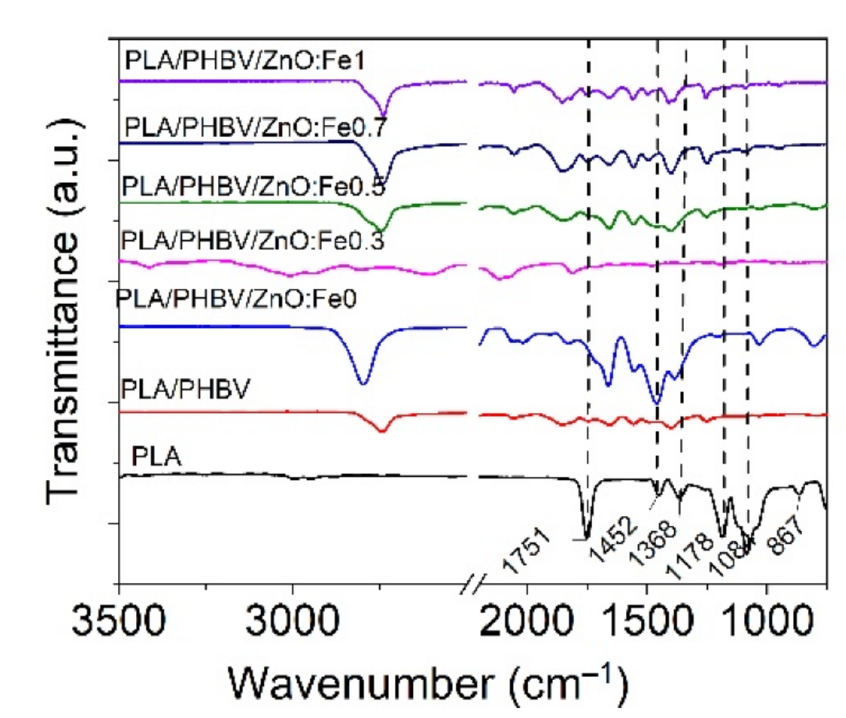
Figure 7. Normalized FT-IR spectra for PLA/PHBV/ZnO:Fex electrospun nanosystems compared with those for PLA film and PHBV nanofibers in the range of 3500–750 cm − 1